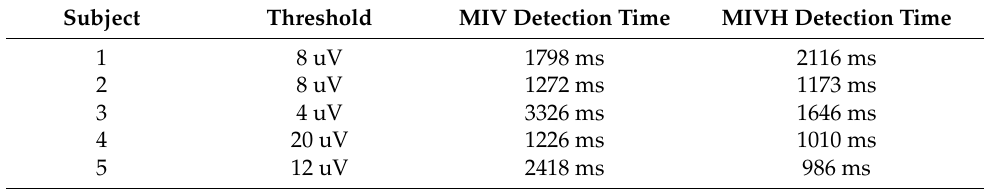
Table 2. Subjects’ threshold results with the average detection time in MIV and MIVH